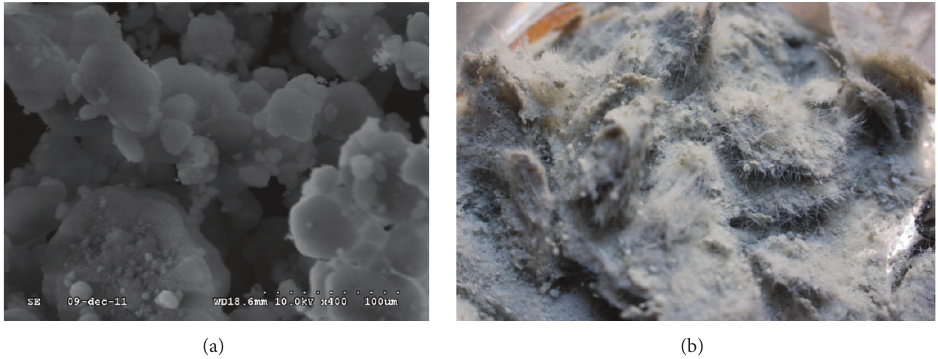
Figure 3: Scanning electron image (a) [13] and real image (b) of silica powders (taken by authors).